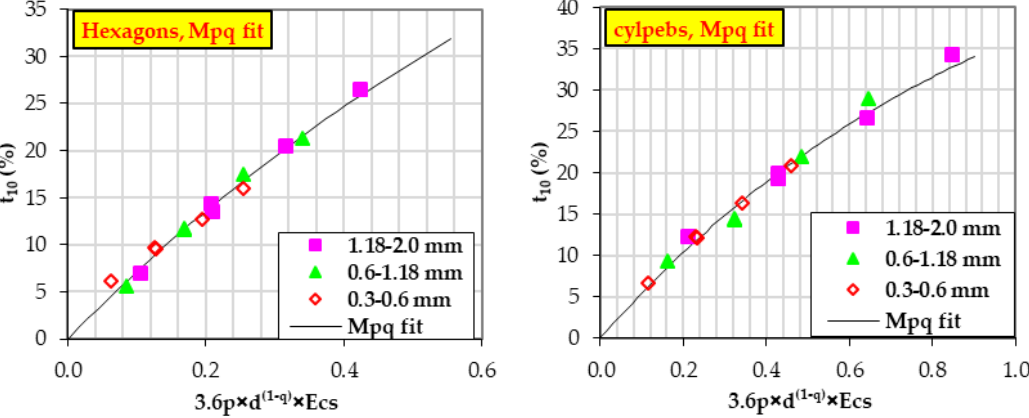
Figure 8. JK size-dependent model fitting with the test data.